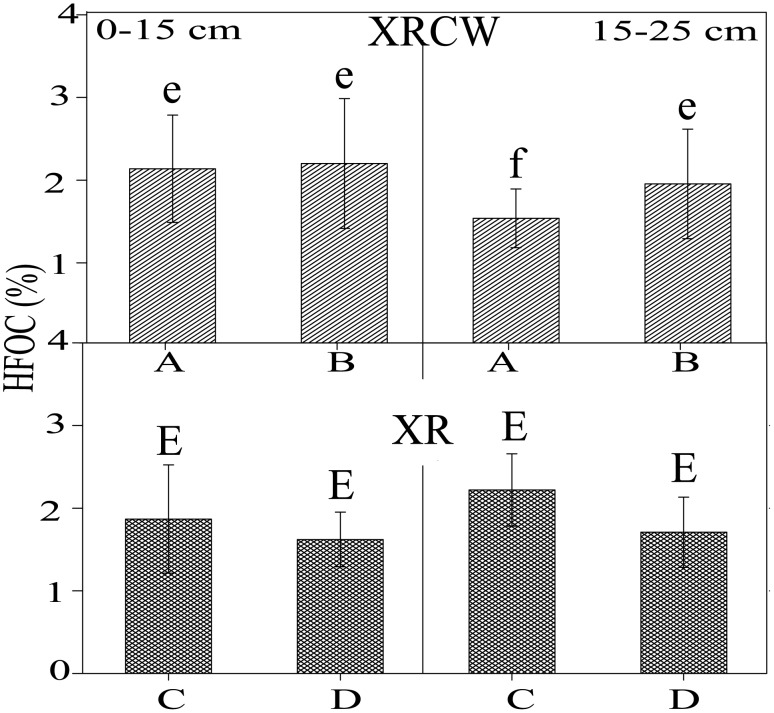
The spatial and vertical distribution of heavy fraction organic carbon (HFOC).Bar plots showing the spatial and vertical (0–15 cm vs. 15–25 cm) distribution of heavy fraction organic carbon (HFOC) in the Xinxue River (XR) and Xinxue River Constructed Wetland (XRCW). A = upstream location of XRCW; B = downstream location of XRCW; C = upstream location of XR; D = downstream location of XR. Bars sharing the same letter are not significant at α = 0.05 (Duncan Test).